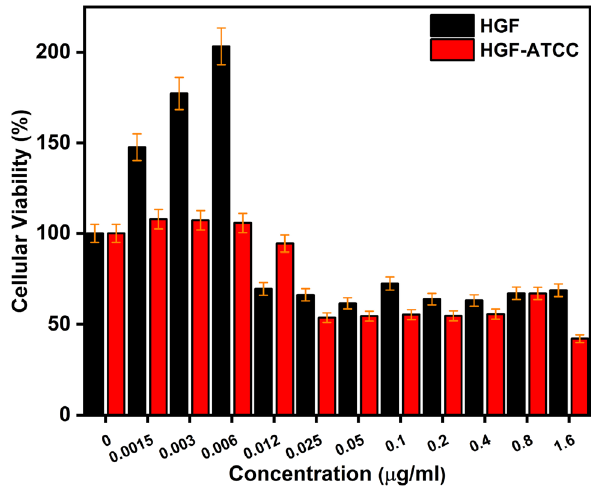
Figure 7: Cytotoxicity evaluation of HGF primary cells and HGF ATCC cell line using MTT after incubating AgNPs for 24 h ( n = 36 )